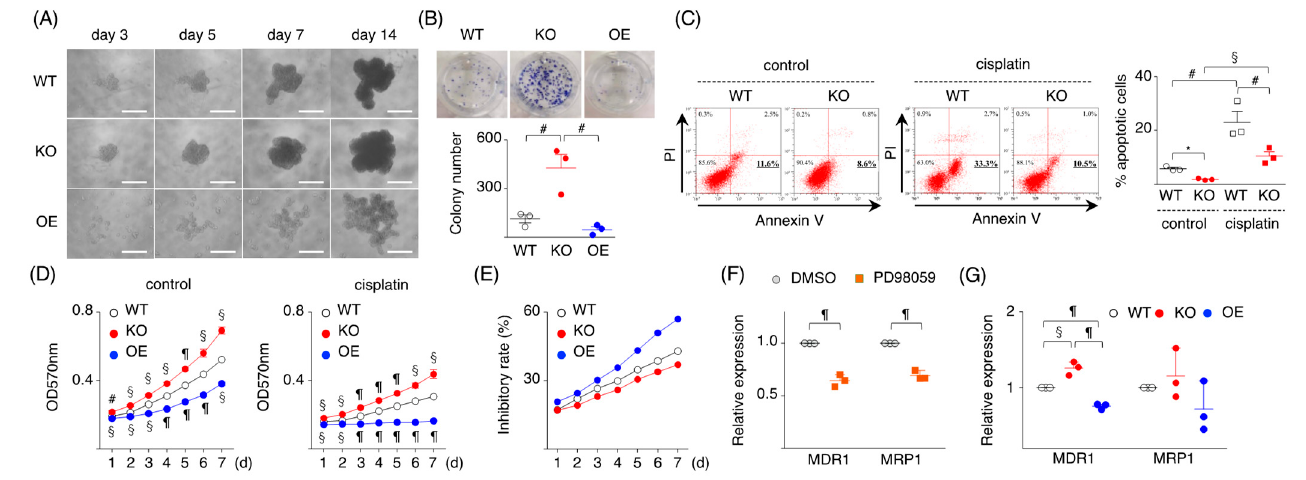
Figure 3. SPRED2 as a regulator of cancer cell stemness. ( A ) WT, SPRED2-KO, and SPRED2-OE cells (1000 cells) were cultured in 96-well ultra-low attachment plates for 14 days. Representative photos are shown. Scale bars: 100 µ m. ( B ) Spherical colonies were dissociated, and 1 × 10 4 cells were planted into a 6-well plate, and cultured for an additional 14 days. Upper panel, representative photos are shown. Lower panel, colony numbers in 6-well plates were counted ( n = 3, each). ( C ) WT and SPRED2-KO cells (10 6 cells) were cultured with or without cisplatin (10 µ g/mL) for 24 h. Left panel, cells were stained with FITC-Annexin V and PI, and the percentage of apoptotic cells was analyzed by flowcytometry. Right panel, the %apoptotic cells were evaluated ( n = 3, each). ( D ) WT, SPRED2-KO, and SPRED2-OE cells were treated with or without cisplatin (10 µ g/mL) for 24 h. Cell proliferation was evaluated by MTT assay ( n = 3, each). ( E ) Percent inhibitory rate was calculated by (1-cisplatin: A570/control: A570) × 100. ( F ) WT cells were treated with 20 µ M PD98059 or vehicle (DMSO) for 24 h. MDR1 and MRP1 mRNA expressions in cell extracts were examined by RT-qPCR ( n = 3, each). ( G ) The mRNA expressions of MDR1 and MRP1 in WT, SPRED2-KO and SPRED2-OE cell lysates were evaluated by RT-qPCR ( n = 3, each). # p < 0.05, § p < 0.01, ¶ p < 0.001, * p < 0.0001, two-tailed unpaired t